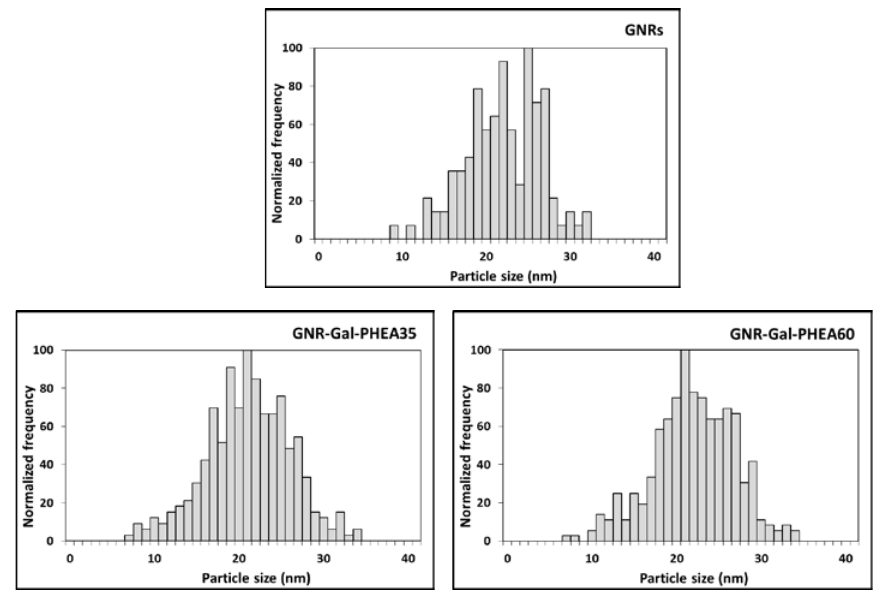
Figure 3. Particle size distributions of GNRs, GNR-Gal-PHEA35 and GNR-Gal-PHEA60 as obtained using spICP-SFMS. Table 4. spICP-SFMS results of bare and glycoconjugated GNRs (N = 2, mean +/- SD).